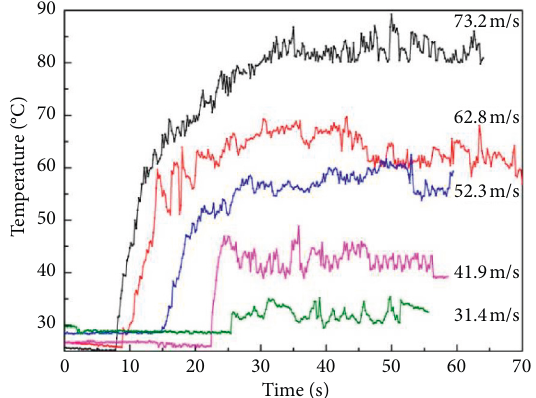
Figure 3: The temperature evolution at different speeds.